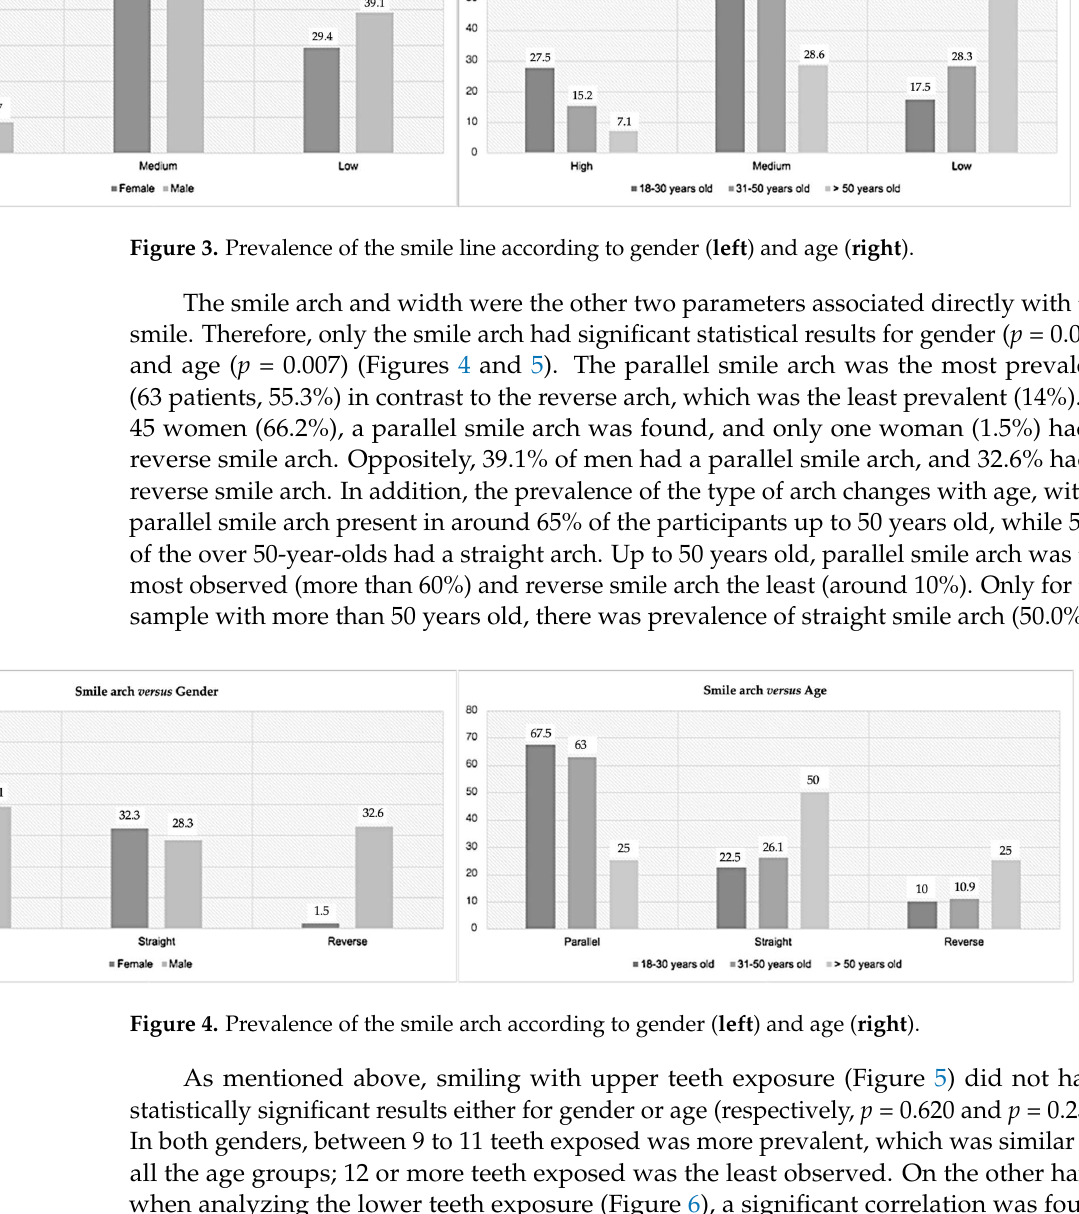
Figure 2. Prevalence of the upper lip curvature according to gender ( left ) and age ( right ).